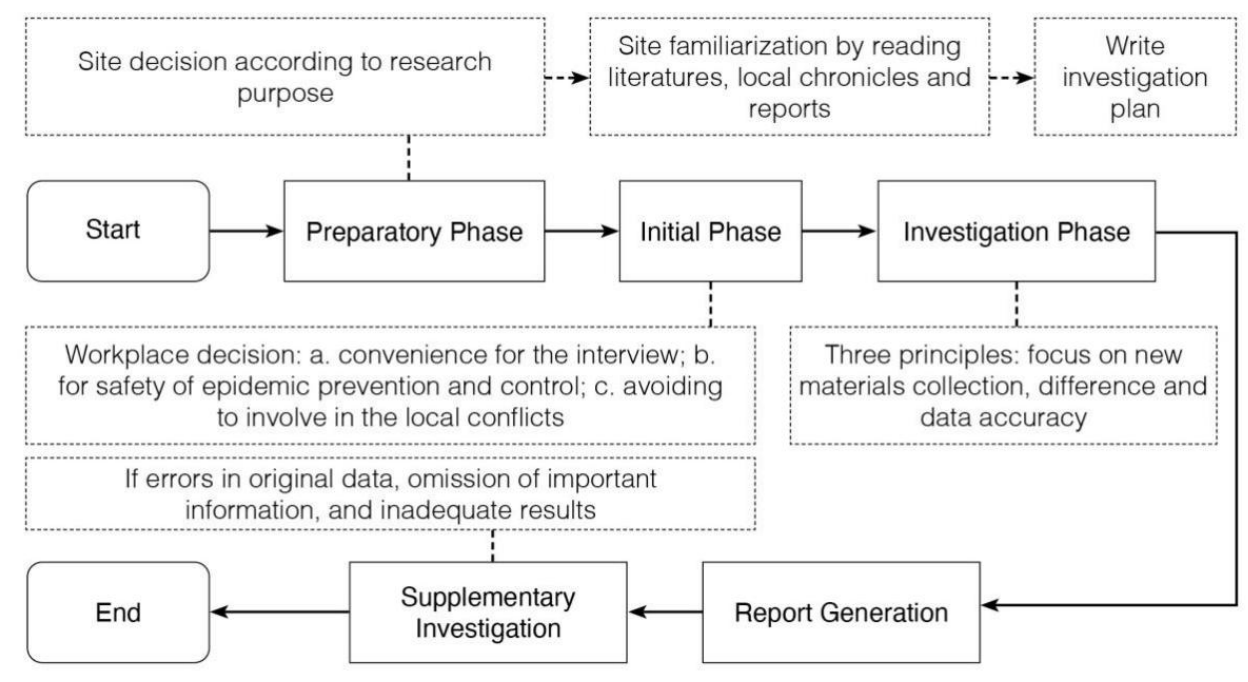
Figure 2. Research Figure 2. Research framework.